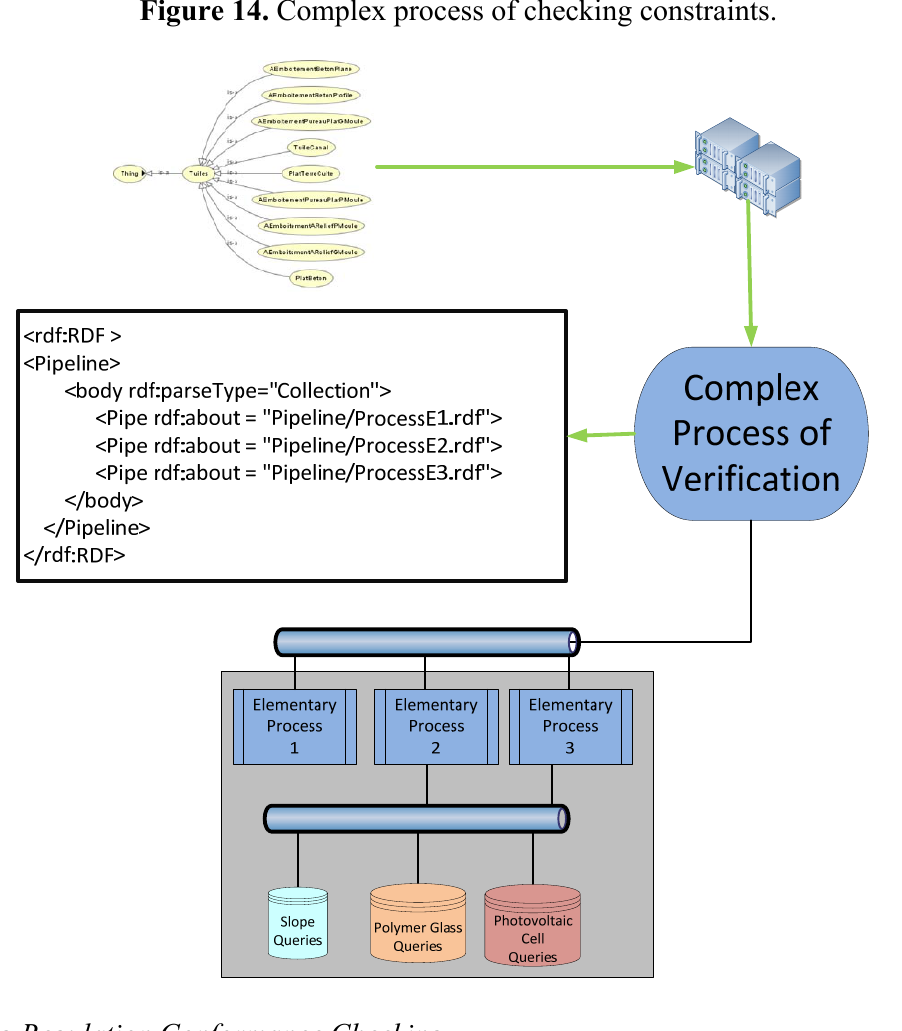
Figure 13. A SPARQL query template for generating a complex process.